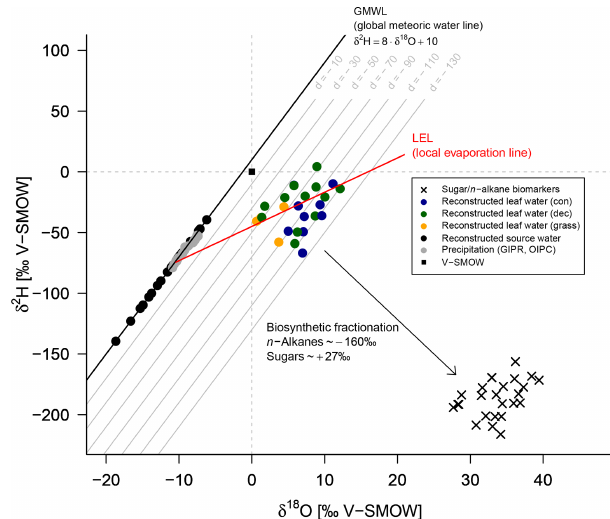
Figure 8. δ 2 H vs. δ 18 O diagram illustrating the coupled δ 2 H n -alkane – δ 18 O sugar approach: measured δ 2 H n -alkane and δ 18 O sugar values, reconstructed δ 2 H leaf-water and δ 18 O leaf-water (according Eqs. 8 and 9), and reconstructed δ 2 H source-water and δ 18 O source-water in comparison to GIPR and OIPC-based δ 2 H precipitation and δ 18 O precipitation . Abbreviations: con: conifer- ous forest sites ( n = 9); dec: deciduous forest sites ( n = 11); grass: grassland sites ( n =